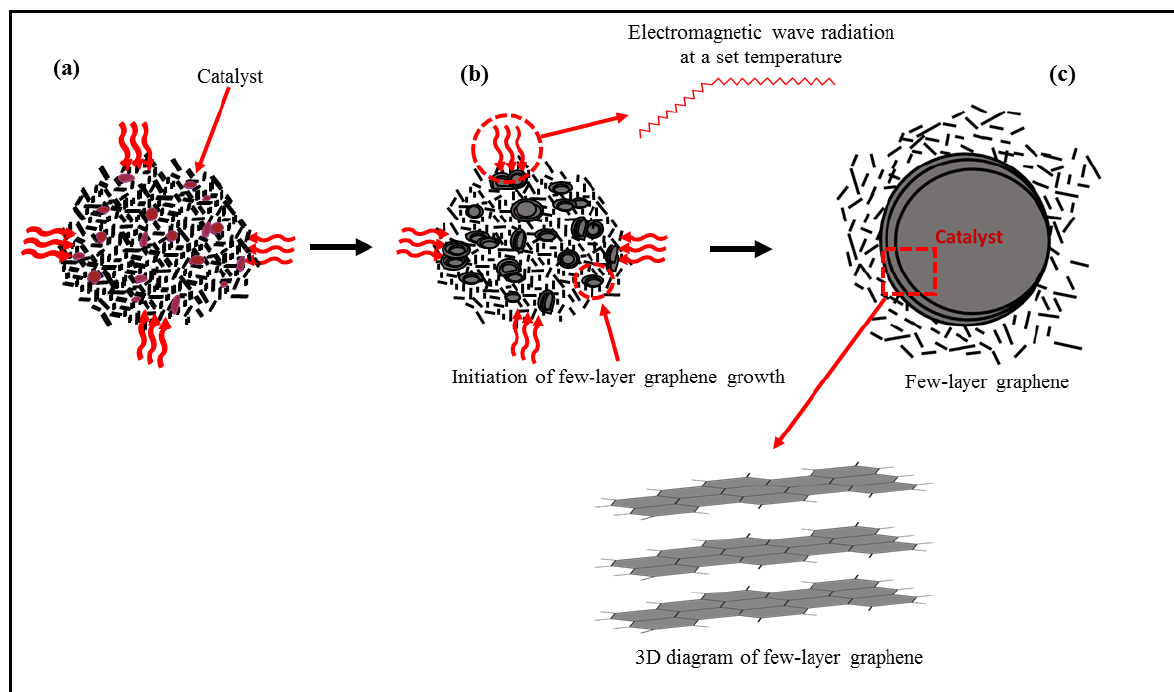
Figure 6. ( a ) Schematic diagram of catalyst particles in an amorphous carbon matrix under continuous microwave heating. ( b ) Initiation of few-layer graphene growth at a set temperature and time. ( c ) Microwave-induced graphitization and few-layer graphene growth around a catalyst particle.